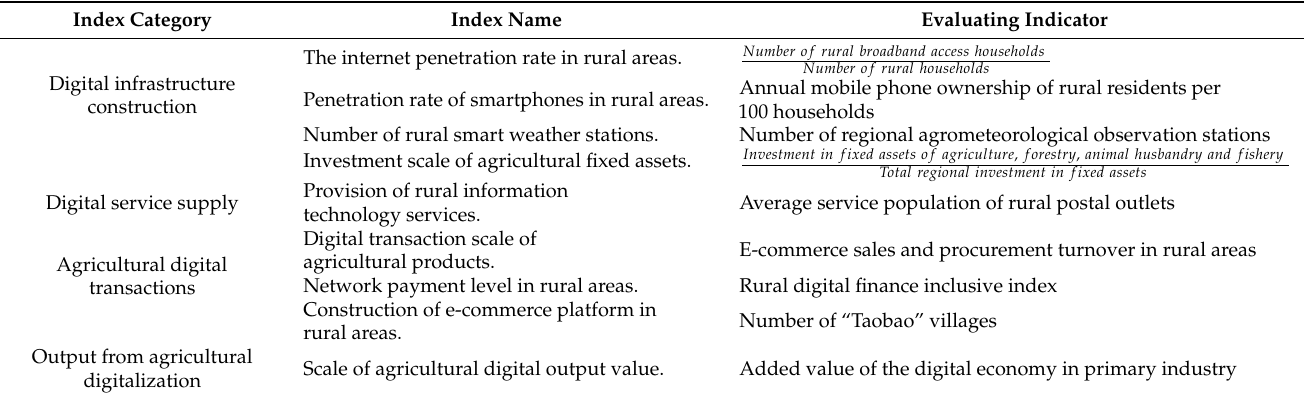
Table 2. Index system of agricultural digital